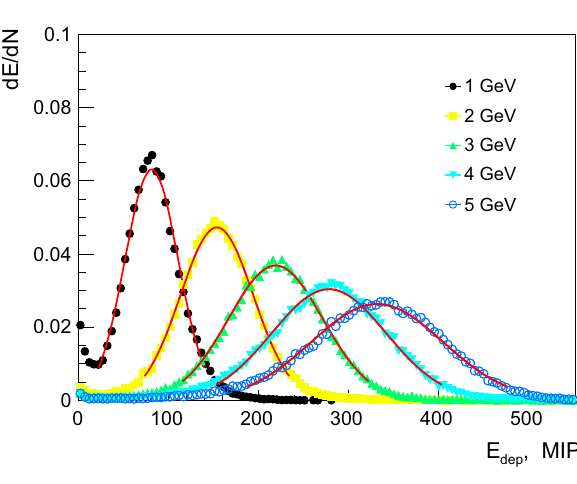
Fig. 15 Distribution of the energy deposited in the calorimeter, dE / dN , for different electron energies. The lines illustrate fits with a Gaussian